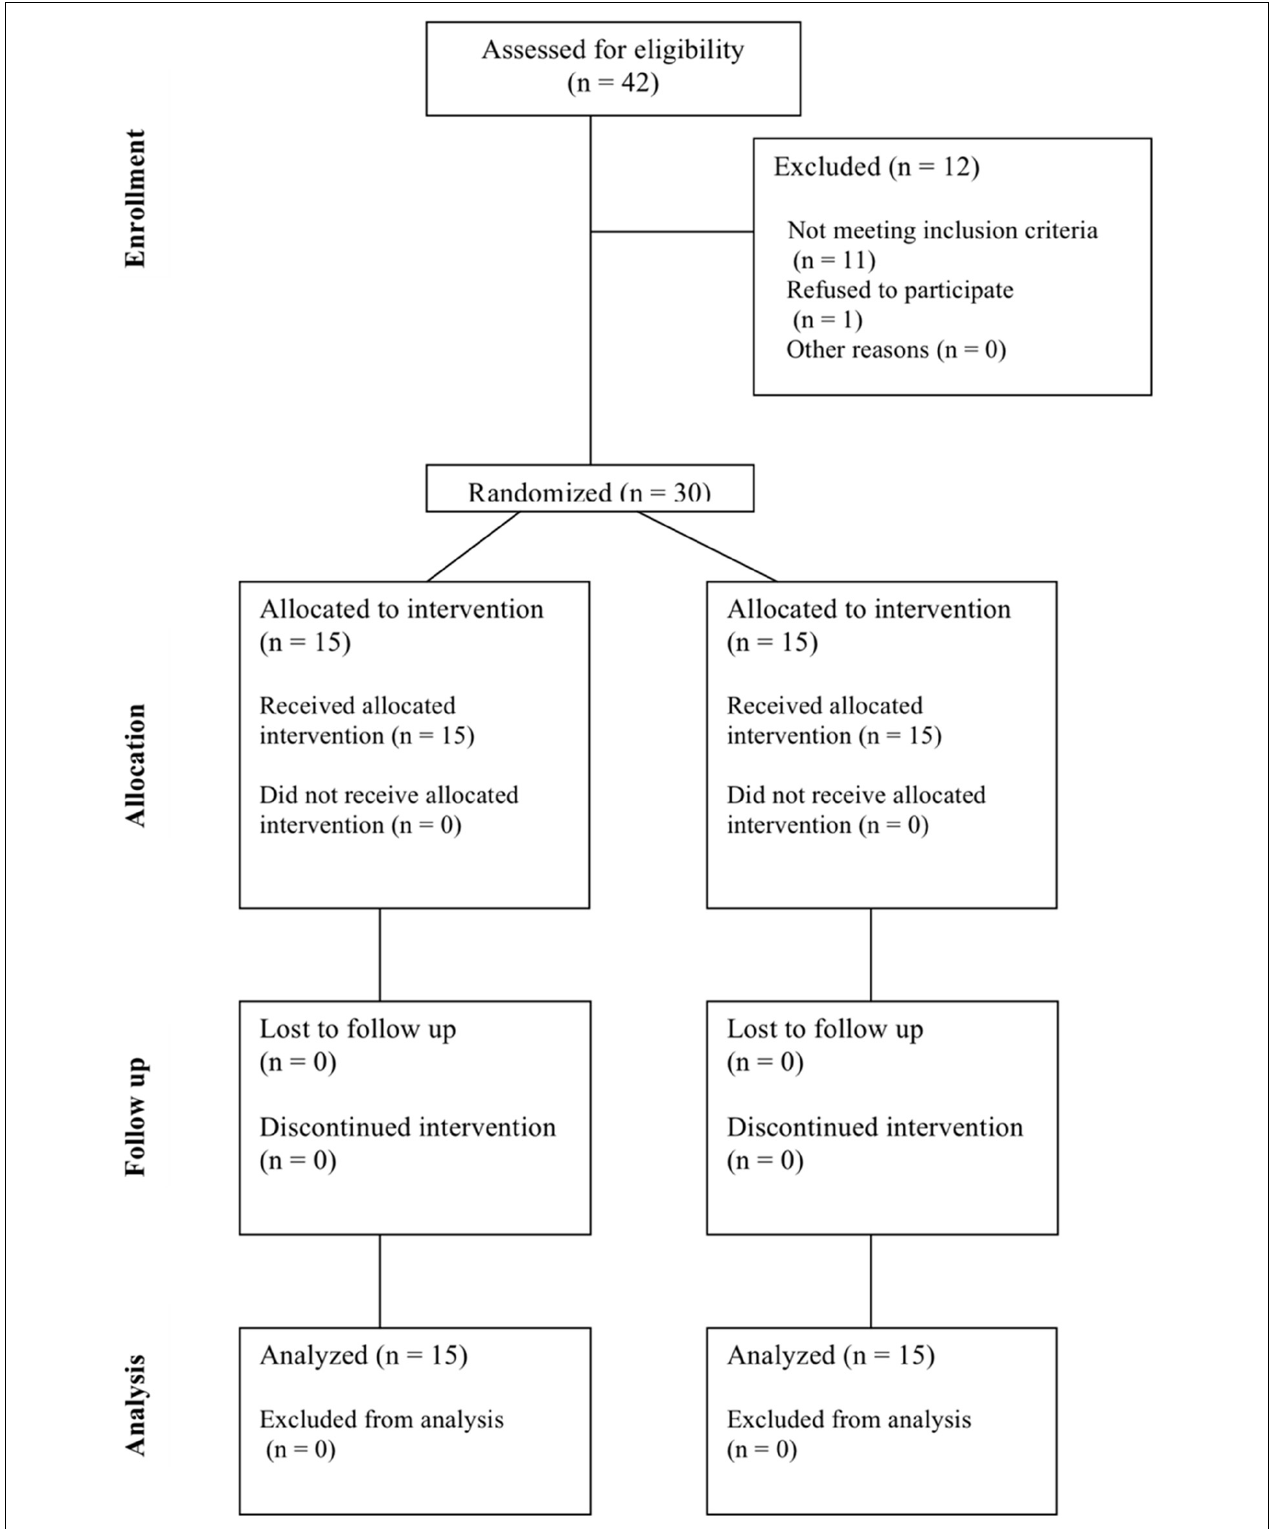
FIGURE 1 | CONSORT flow